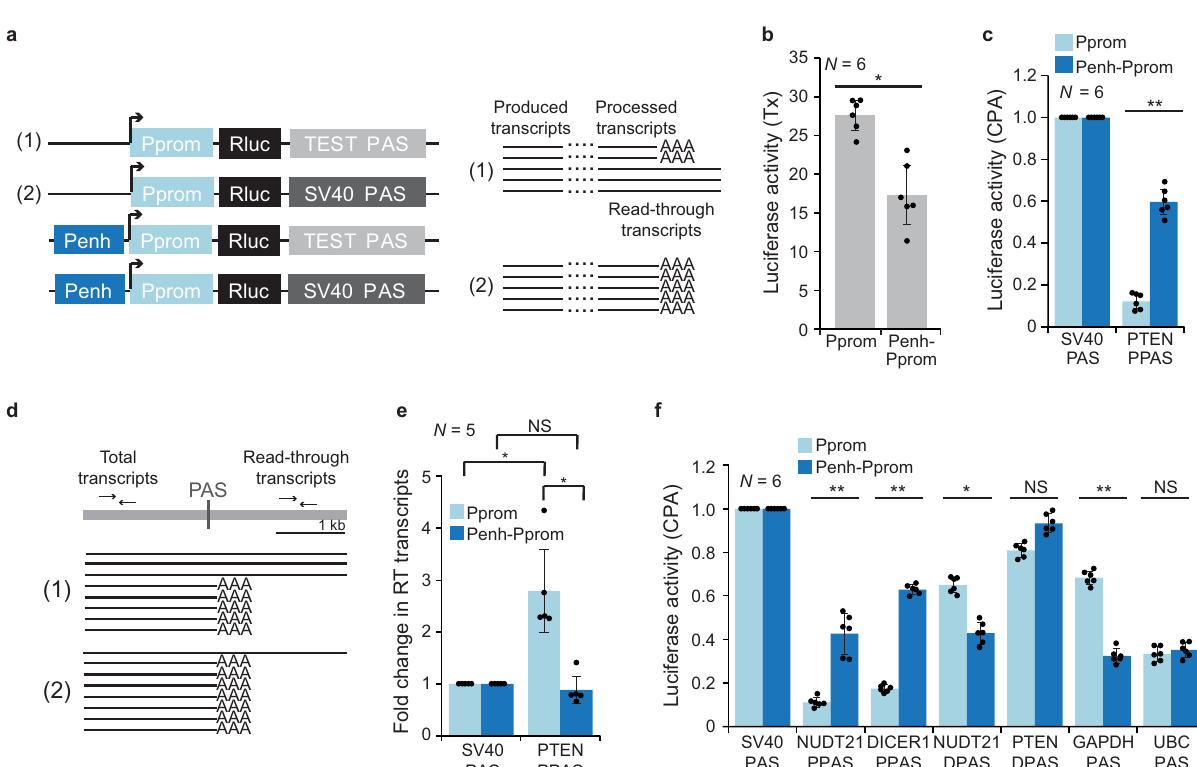
Fig. 2 The PTEN enhancer increases CPA activity of proximal PAS. a Schematic of luciferase reporter constructs to investigate enhancer-dependent transcriptional activity and CPA activity. The transcription start site is indicated by the arrow. Rluc, Renilla luciferase. Schematic showing the expected produced and processed reporter transcripts for the indicated constructs. In reporter (2), the strong SV40 PAS cleaves all produced transcripts (indicated by AAA to denote a poly(A) tail) and measures transcriptional activity. In reporter (1) a weaker PAS does not cleave all produced transcripts, thus resulting in read-through transcripts. The relative CPA activity of a test PAS corresponds to the ratio of the luciferase activities obtained from the test PAS reporter over the SV40 PAS reporter when transcribed from the same promoter. b Transcriptional activity (Tx) of the Pprom reporter in the presence (Penh-Pprom) or absence (Pprom) of the PTEN enhancer obtained by luciferase activity of the SV40 PAS reporters. Transcriptional activity represents renilla luciferase activity that was normalized by fi re fl y luciferase activity. Shown is mean ± std of n = 6 biologically independent experiments. Tx, transcription. Two-tailed t- test for independent samples was performed. * P = 0.002. c Luciferase activity corresponding to the relative CPA activity of the PPAS of PTEN when transcribed from the PTEN promoter in the absence or presence of the PTEN enhancer. Shown is mean ± std of n = 6 biologically independent experiments. Two-tailed t-test for independent samples was performed. ** P = 1 × 10 − 8 ; NS not signi fi cant. d Schematic for measuring read-through transcription of the reporter constructs shown in ( a ). A primer pair located upstream of the PAS measures the total number of transcripts produced, whereas a primer pair located downstream of the PAS measures the number of read-through transcripts. e Fold change in read-through (RT) transcripts obtained from the indicated reporter constructs. Shown is mean ± std of n = 5 biologically independent experiments. Two-tailed t -test for independent samples was performed. Pprom: SV40 vs PTEN PPAS * P = 0.002; Penh-Pprom: SV40 vs PTEN PPAS, P = 0.42; PTEN PPAS: Pprom vs Penh-Pprom, * P = 0.002. f As in ( c ), but additional PAS are shown. DPAS, distal PAS. Shown is mean ± std of n = 6 biologically independent experiments. Two-tailed t -test for independent samples was performed. ** P = 1 × 10 − 6 ; * P = 0.001; NS not signi fi cant. Source data for fi gures ( b , c , e , and f ) are provided as a Source Data fi